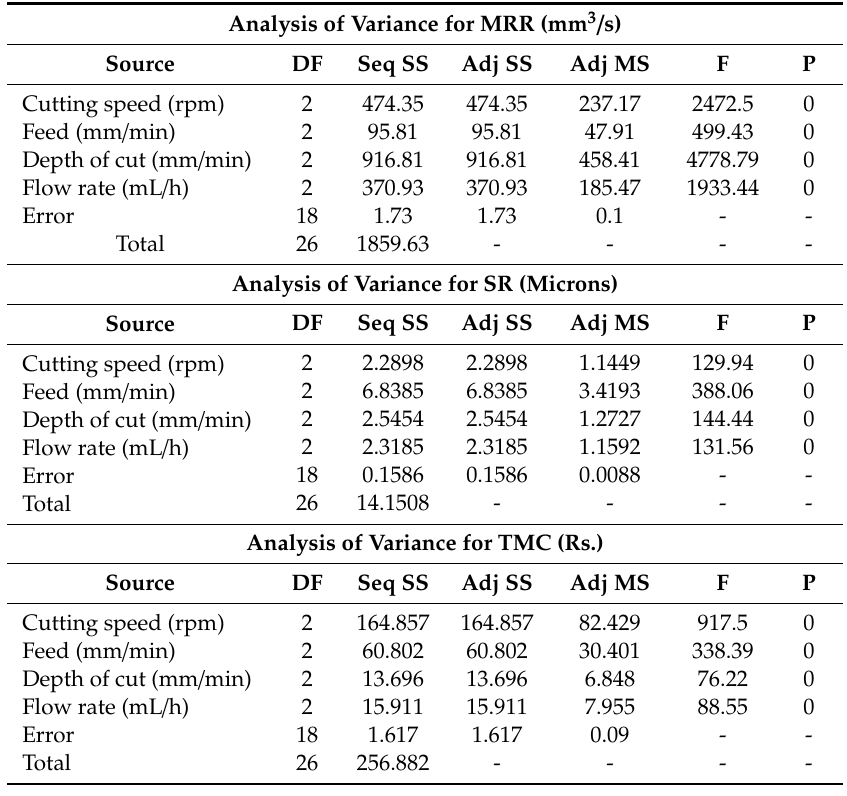
Table 10. ANOVA analysis on performance